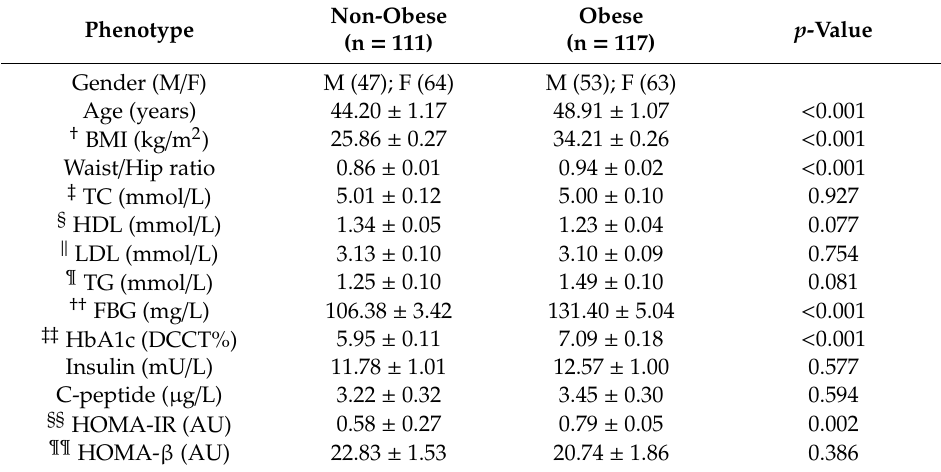
Table 2. Characteristics of non-obese and obese study